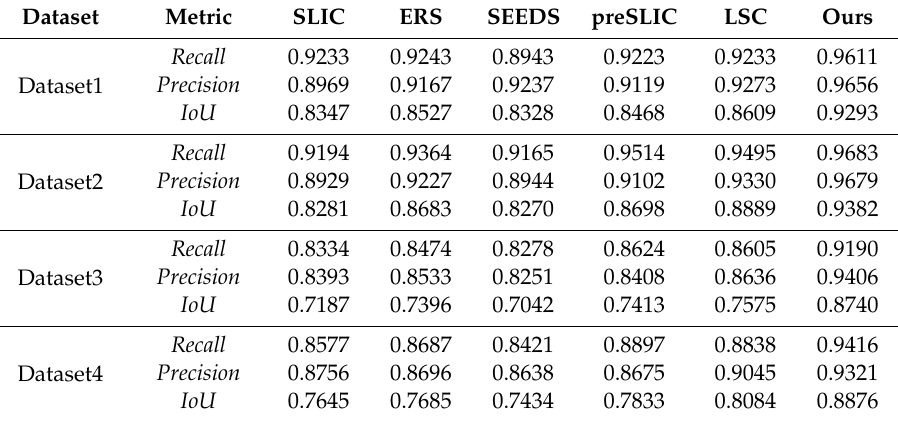
Table 5. Superpixel-based building extraction results on the four datasets after regularization